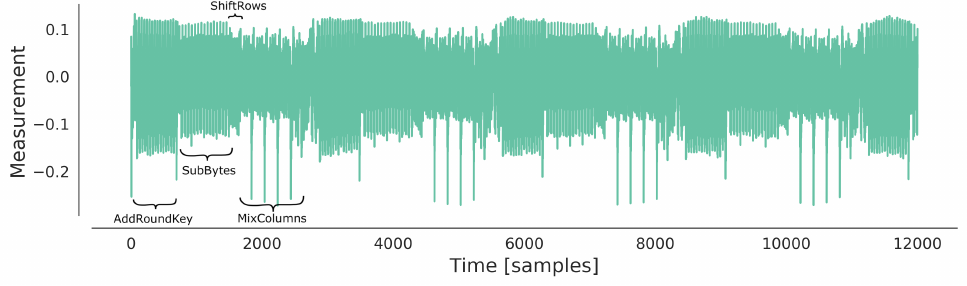
Figure 18: Example trace of the first four rounds of AES-CTR on a